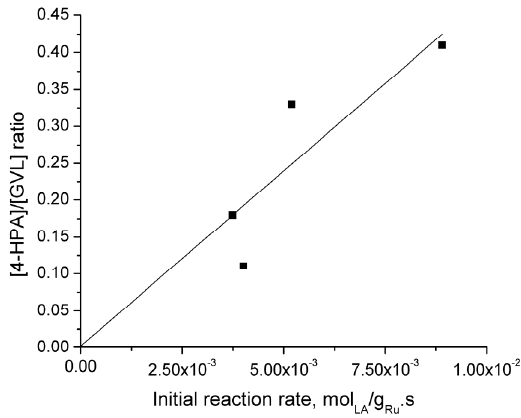
Figure 11. [4 ‐ HPA]/[GVL] ratio (concentration based) vs. initial reaction rate after 2 h batch time.